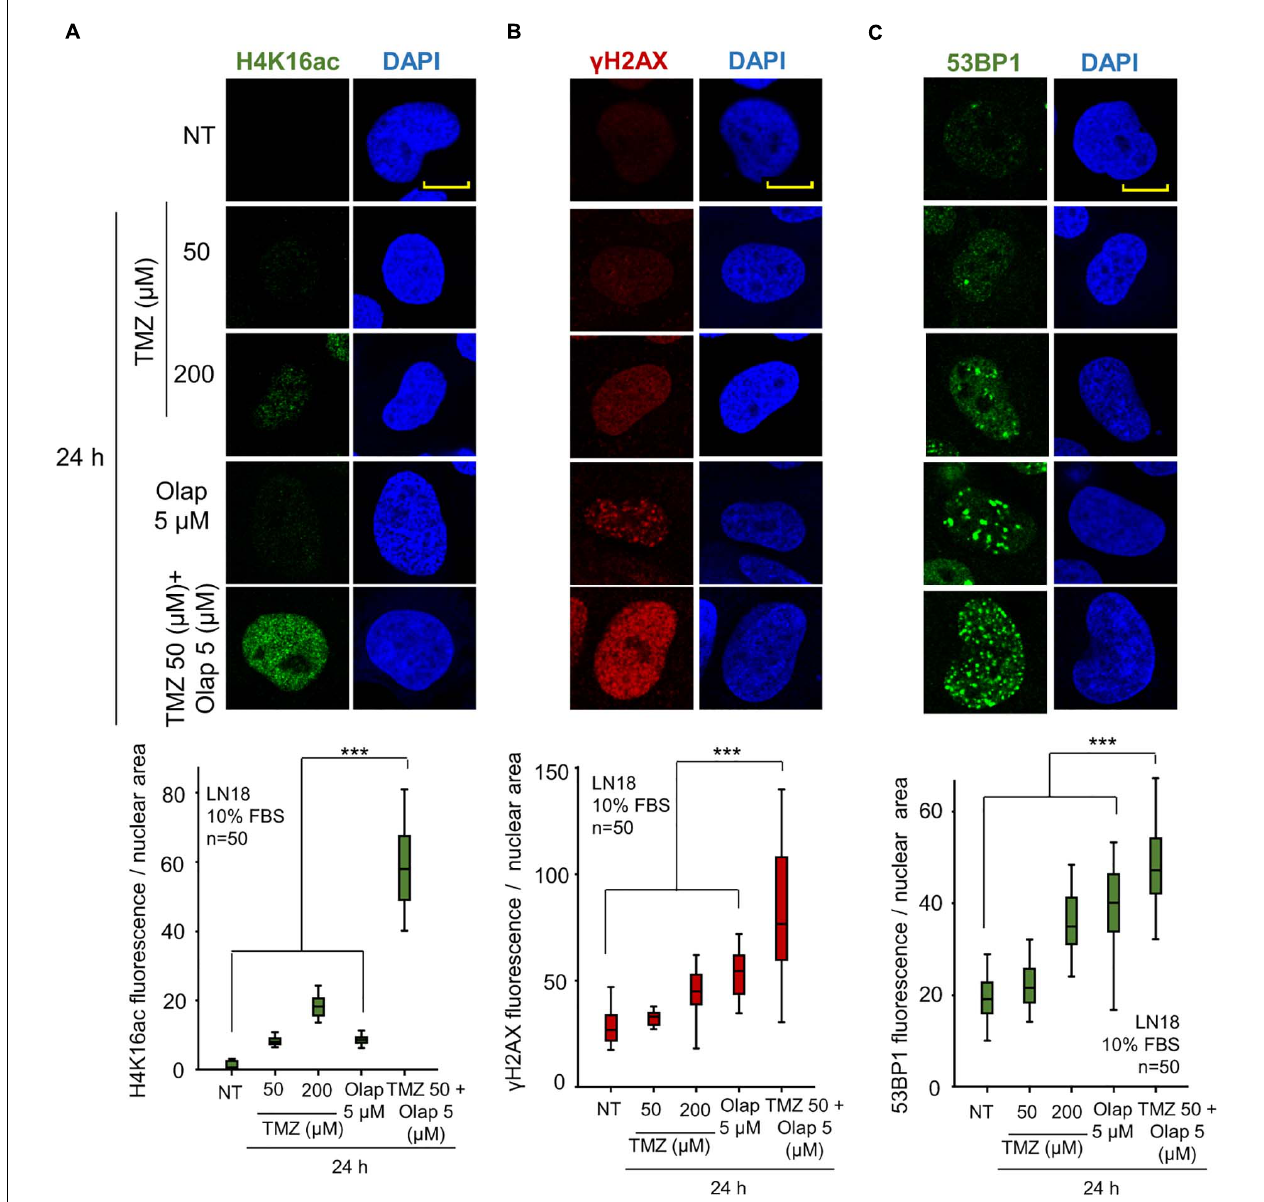
FIGURE 1 | Effect of the combination of TMZ and olaparib on H4K16 acetylation levels, γ H2AX and 53BP1 foci formation in response to DNA damage in LN-18 glioblastoma cells. (A) Effect of TMZ 50 and 200 µ M, olaparib 5 µ M and the combination of TMZ 50 and olaparib 5 µ M on H4K16ac shown by immunofluorescence (IF). (B) Effect of TMZ 50 and 200 µ M, olaparib 5 µ M and the combination of TMZ 50 and olaparib 5 µ M on γ H2AX shown by IF. (C) Effect of TMZ 50 and 200 µ M, olaparib 5 µ M and the combination of TMZ 50 and olaparib 5 µ M on 53BP1 shown by IF. The quantification of fluorescence levels per nuclear area from fifty cells in triplicate is shown at the bottom. NT: no treatment. Scale bar = 10 µ m. *** p < 0.001. Field images shown in Supplementary Figure 1